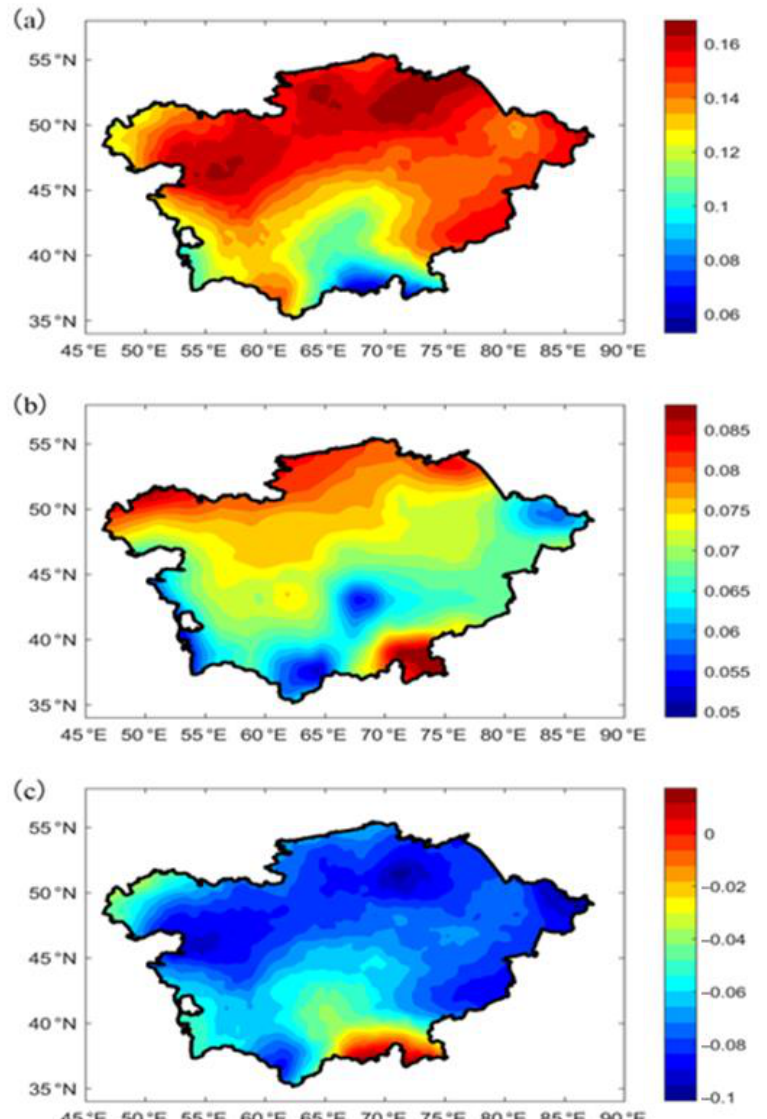
Figure 5. Spatial distributions of the annual mean SAT trends of ( a ) the observed data (by the CRU), ( b ) the multi-model ensemble (MME), and ( c ) the MME minus the CRU data, 1901–2005. ( b ) the multi-model ensemble (MME), and ( c ) the MME minus the CRU data,